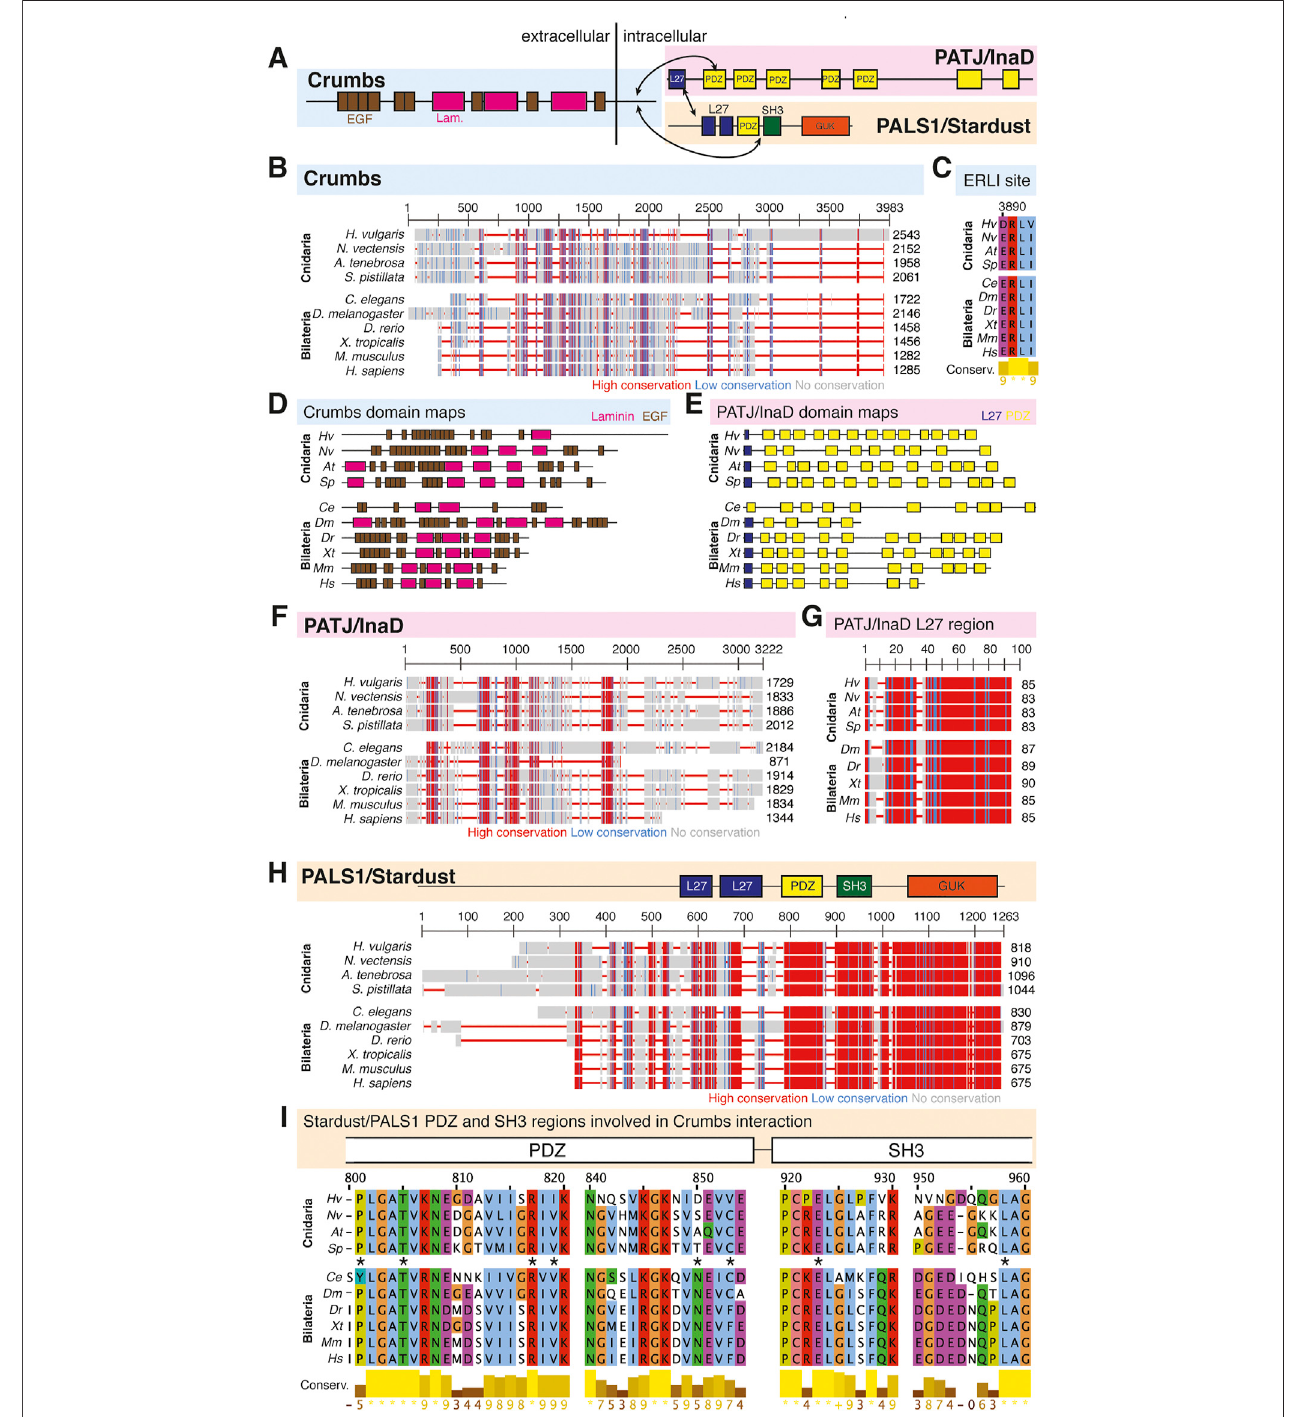
FIGURE4| TheCrumbscomplexde fi nestheapicaldomainandisconservedacrossbilateriansandcnidarians. (A) RepresentationofthehumanCrumbscomplex withCrumbs,PALS1/Stardust,PATJ/InaDpictured.Functionaldomainsandexamplesofprotein-proteininteractionsdenoted. (B) FullproteinalignmentofCrumbs. (C) Amino acid alignment of the ERLI motif at the Crumbs C-terminus. (D-E) Domains maps of Crumbs (D) and PATJ/InaD (E) depicting laminin (magenta, D), EGF (brown, D),L27 (navy,E), andPDZ (yellow, E)domainpositions.Proteinlengths drawntoscale. (F) Fullprotein alignmentofPATJ/InaD. (G) ProteinalignmentofPATJ/InaD L27 domain magni fi ed from (F). (H) Full protein alignment of PALS1/Stardust with functional domains depicted in their respective positions. (I) Amino acid alignment of regions within PALS1/Stardust PDZ and SH3 domains. Critical residues involved in binding Crumbs marked with asterisk. For all alignments: COBALT used for all